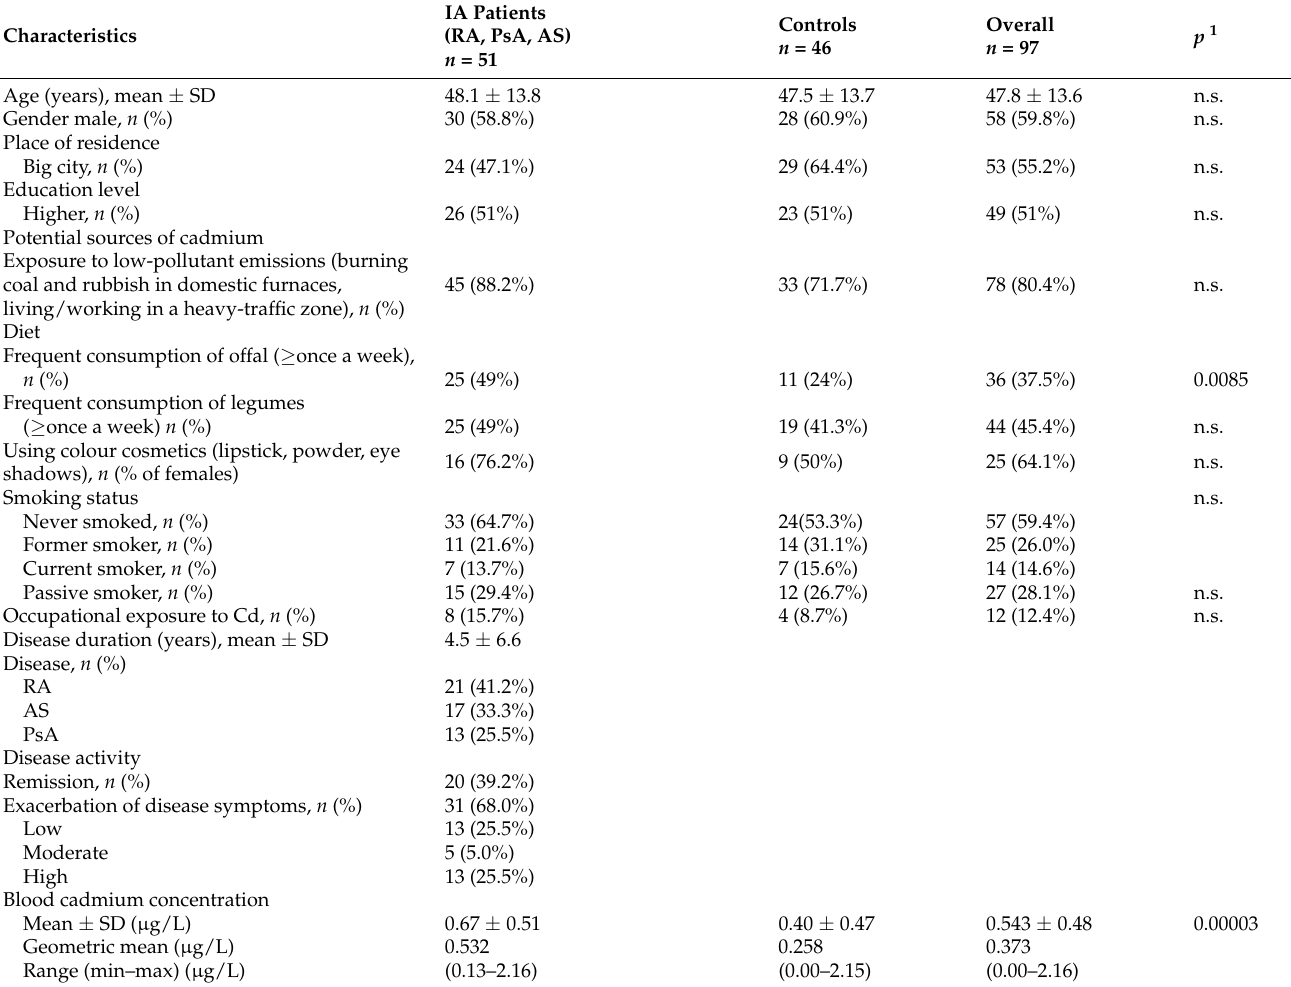
Table 1. Exposure to cadmium and demographic and other basic characteristics of the study